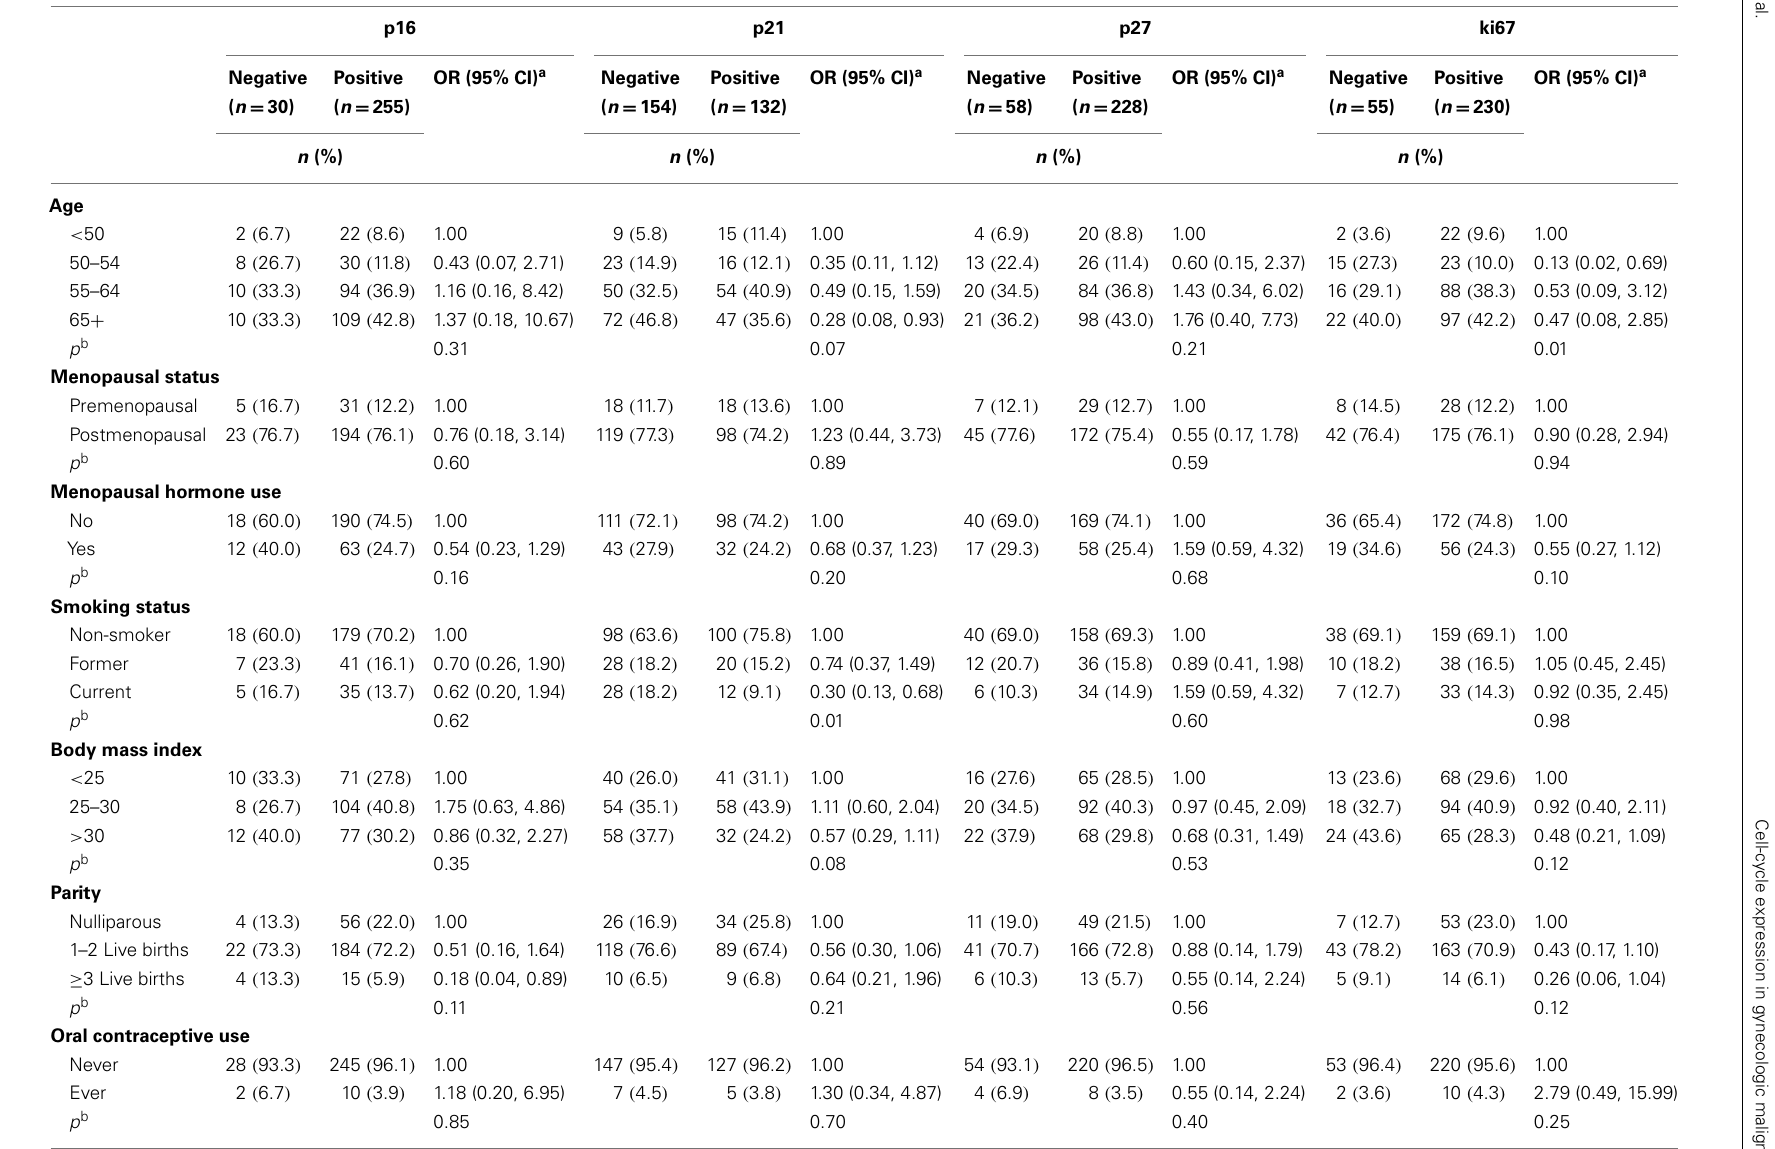
Table 4 |Adjusted odds ratios (ORs) and 95% confidence intervals (CIs) of risk factors and tumor characteristics for positive vs. negative expression of cell-cycle markers among endometrial cancer patients ( n = 289)